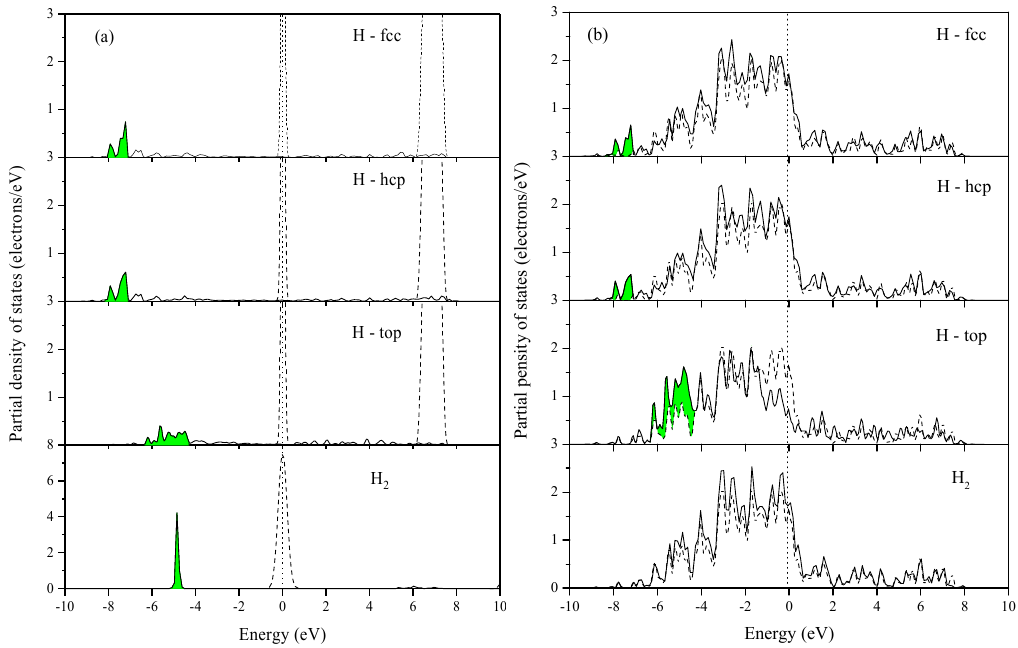
Figure 3. Partial density of states of adsorbates ( a ) and Pt atom near adsorbates ( b ). The vertical dot line indicates the adjusted Fermi level at 0 eV.